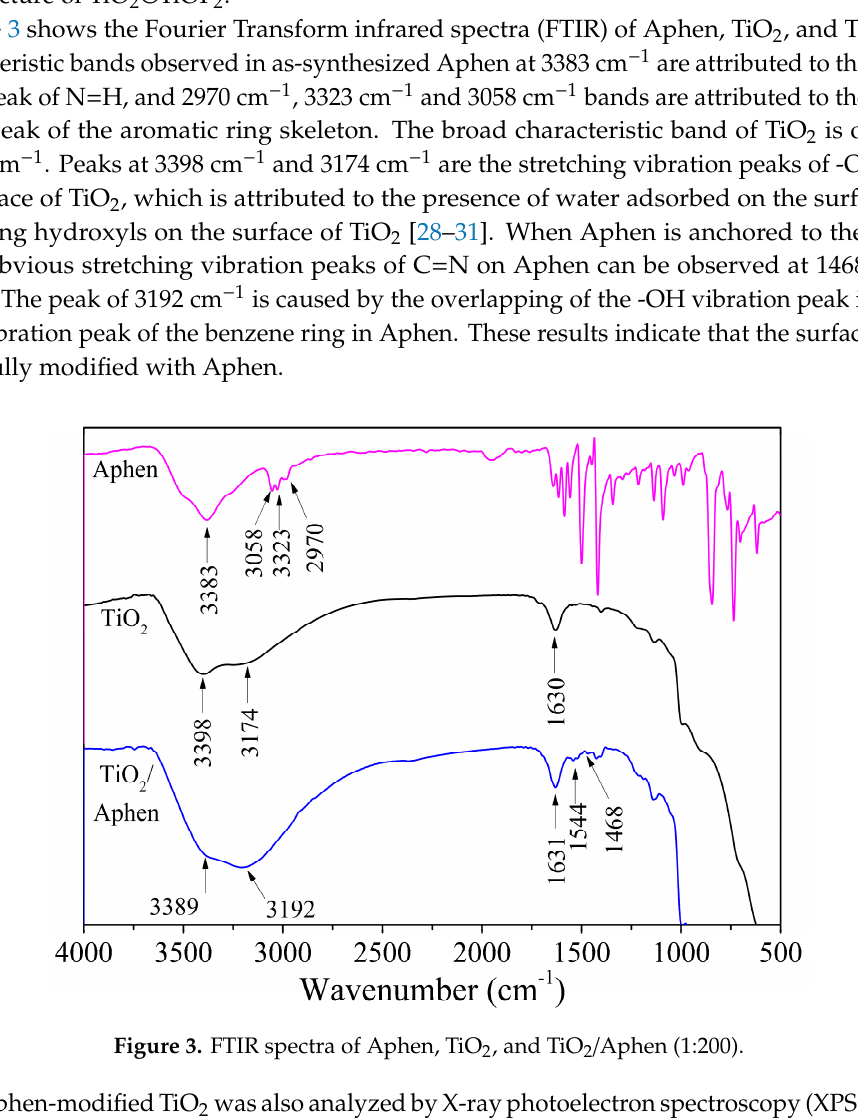
Figure 4. XPS spectra of Ti ( a ) and N ( b ) of TiO2/Aphen.